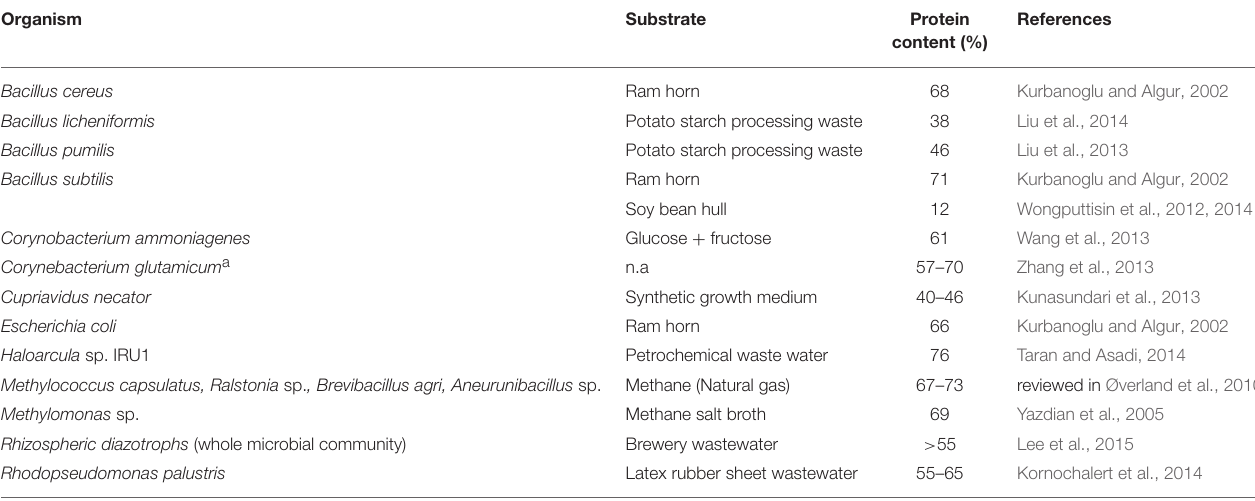
TABLE 3 | Recent reports of bacterial protein content on specific substrates for species investigated as potential sources of